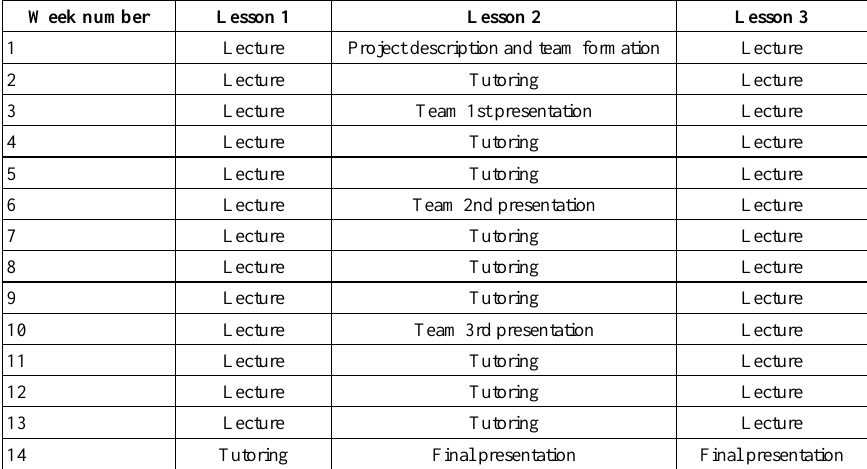
Table 2. Calendar of the activity divided by